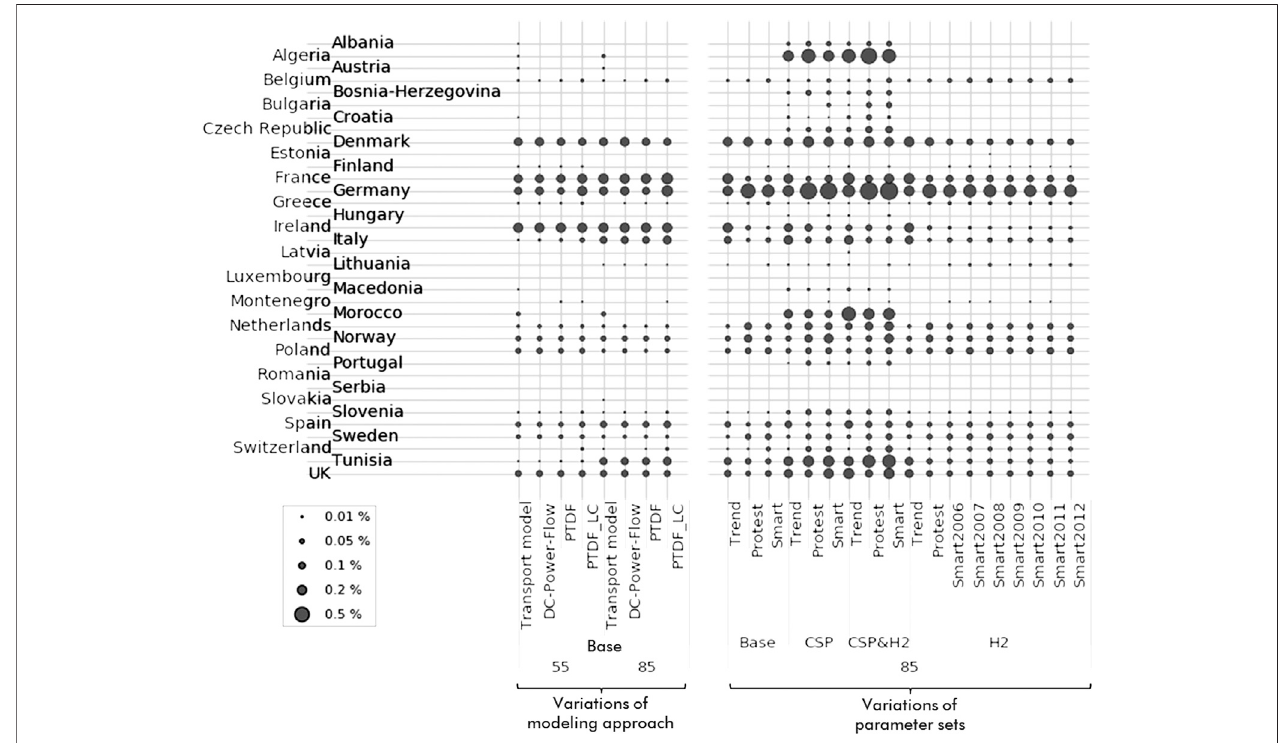
FIGURE 8 | Investments into transmission infrastructures relative to total system costs across all scenarios and countries considered.